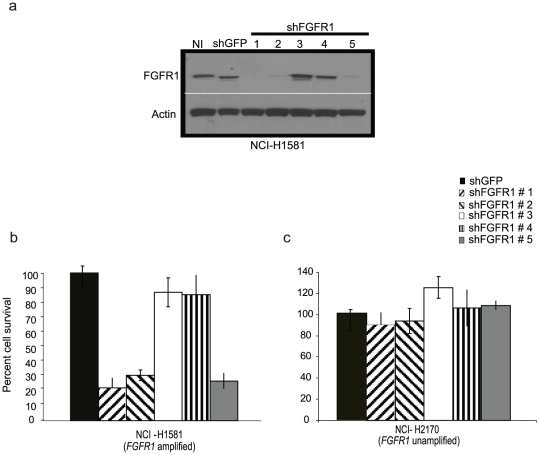
NCI-H1581 cells are sensitive to knock-down of FGFR1 expression.(A) Effects of five FGFR1 shRNA constructs on FGFR1 protein expression in NCI-H1581 cells as assayed by immunoblotting. shRNAs #1, #2 and #5 efficiently knock down endogenous FGFR1 expression in NCI-H1581 cells infected with shRNA-expressing lentiviruses while shRNAs #3 and #4 do not. Actin is shown as a loading control (lower panel). (B and C), infection with three independent FGFR1-suppressing hairpins (#1, #2 and #5) inhibits survival of NCI-H1581 cells over expressing FGFR1 (B) but did not inhibit survival of cells not harboring FGFR1 amplification, NCI-H2170 (C) as assessed by WST assay. NI, no infection. shGFP, control hairpin specific for green fluorescent protein used as a negative control. All results normalized to survival of cells infected with shGFP.